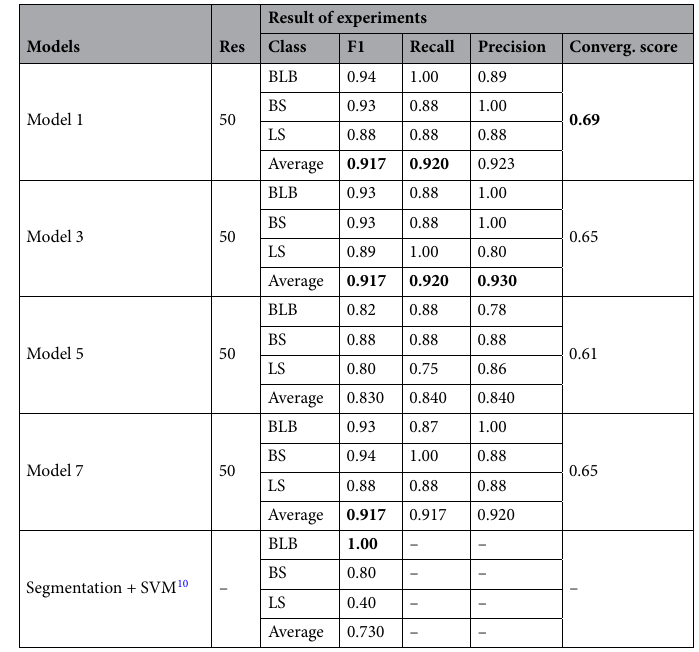
Table 2. The results of the Rice Leaf Disease Dataset experiment. Significant values are in